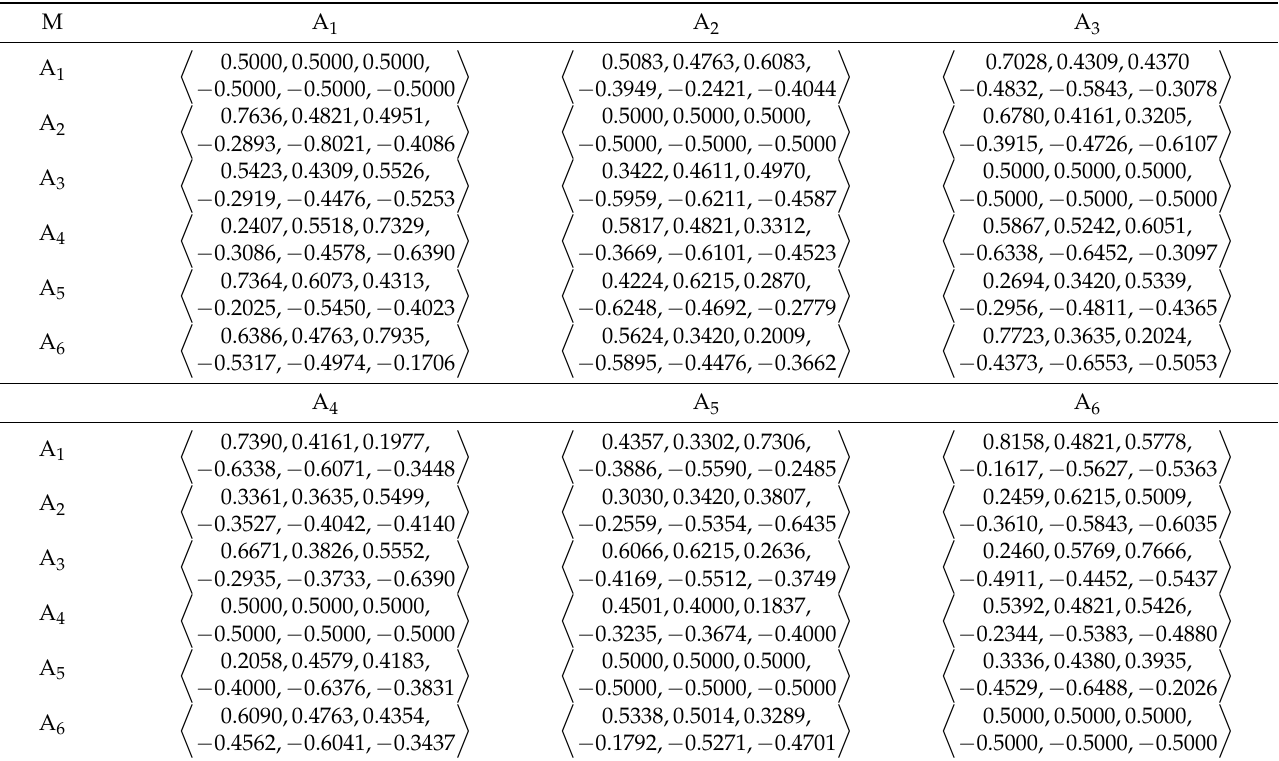
Table 11. The collective BSVNPR of all the above individual